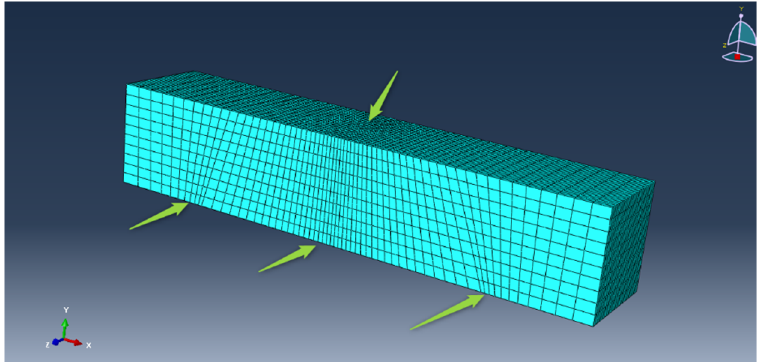
Figure 17. The 3D mesh of the specimen.